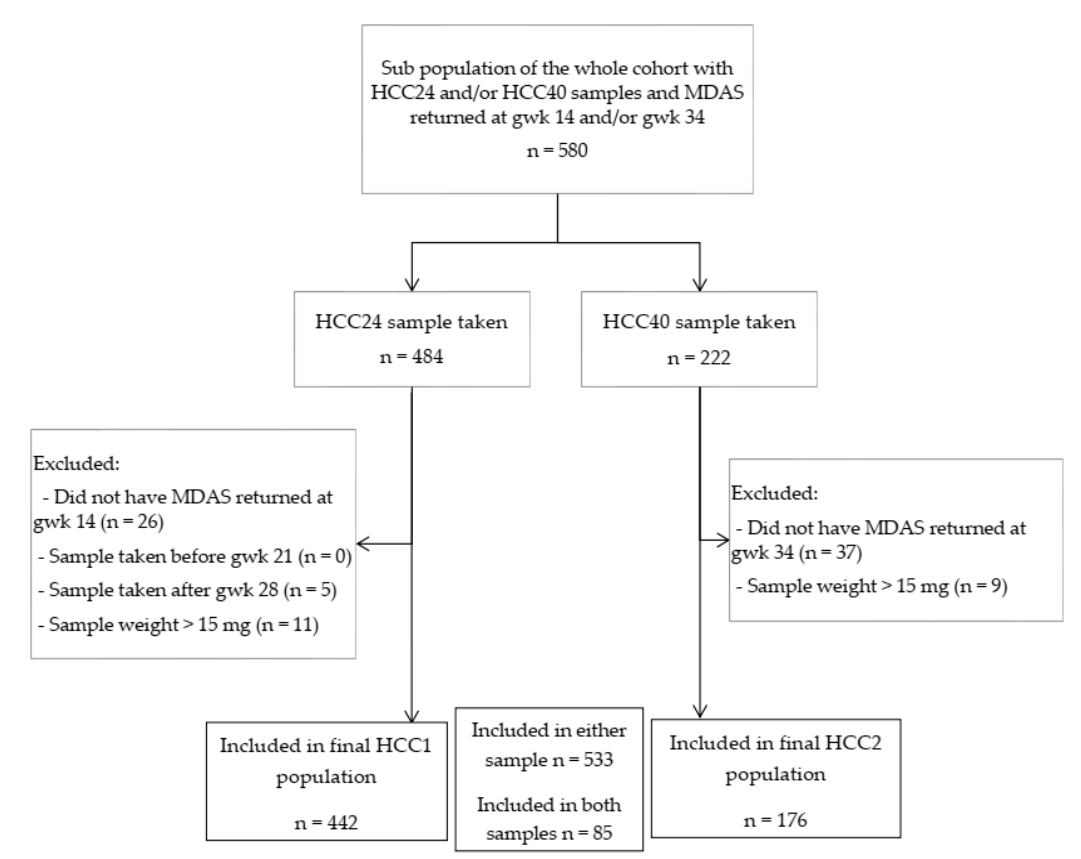
Figure 1. Flow chart of the study design. Abbreviations: gwk = gestational week, HCC24 = hair cortisol concentration measured at gwk 24, HCC40 = hair cortisol concentration measured at delivery, MDAS = Modified Dental Anxiety Scale.